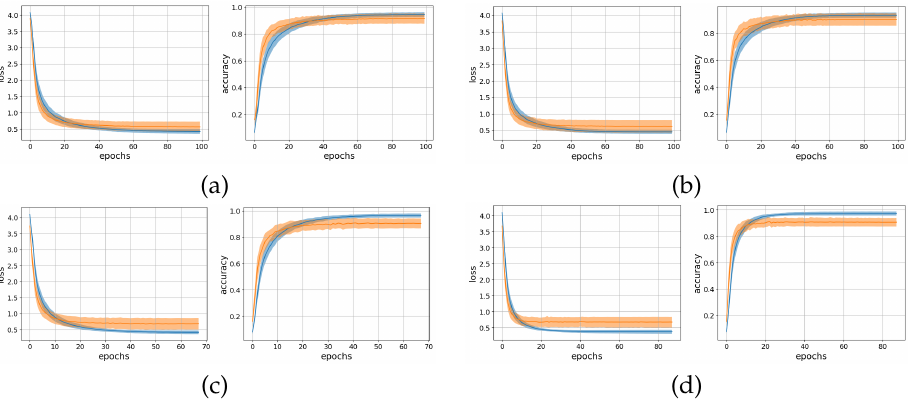
Figure 2. Loss and accuracy curves for training set (blue) and test set (orange) for each of the models. ( a ) AoT300, ( b ) Att300, ( c ) AoT2500, and ( d ) Att2500. The line plots correspond to the subject average, while shaded areas correspond to the standard